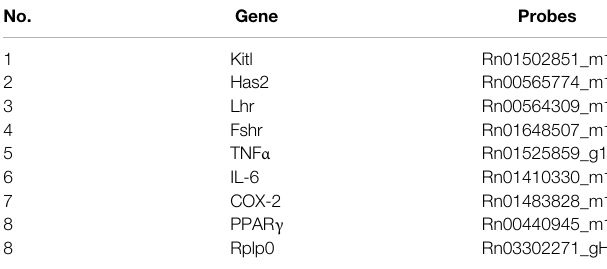
TABLE 1 | The list and sequence of primers used for RT-PCR analysis.